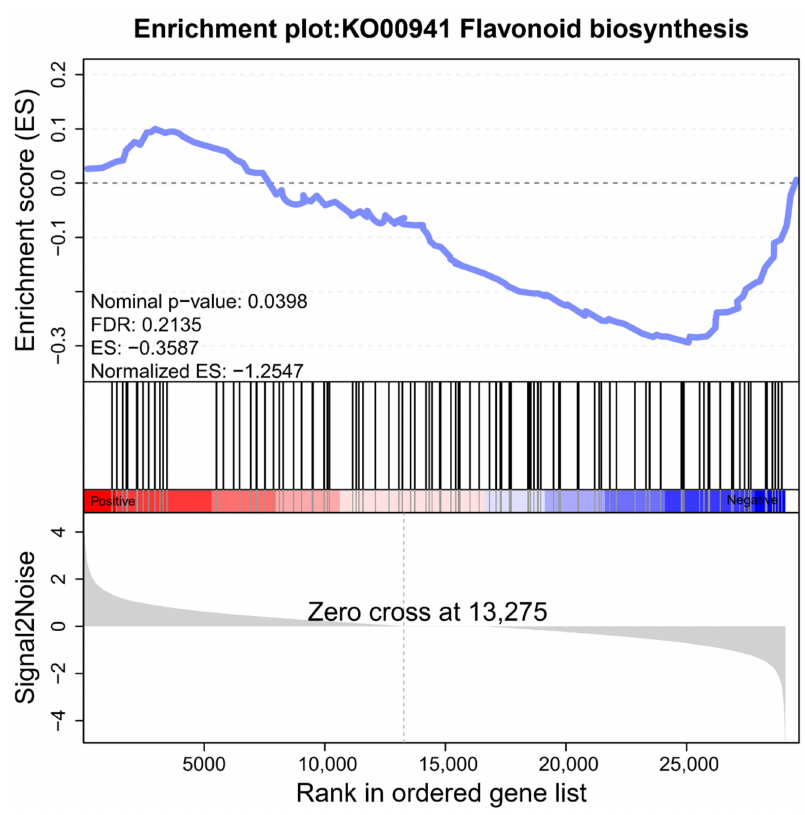
Figure 8. GSEA of all genes in the flavonoid biosynthesis pathway.